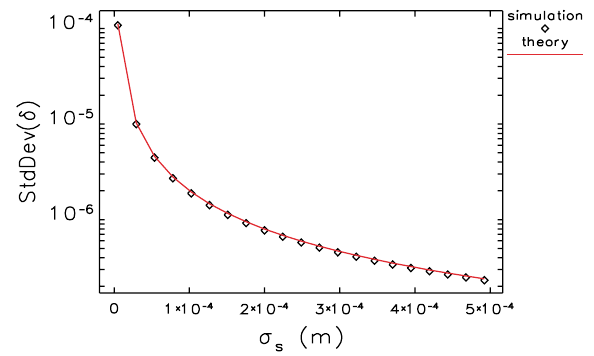
FIG. 5. (Color) Standard deviation of fractional momentum offset vs rms bunch